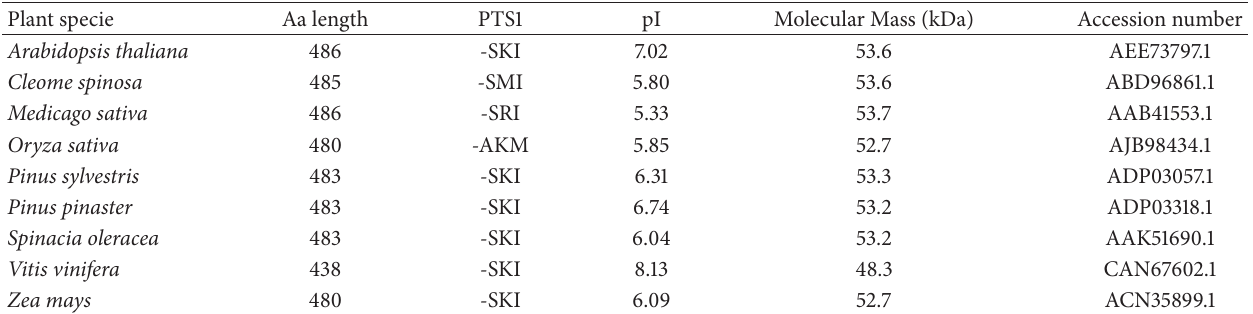
Table 1: Identification of 6PGDH proteins sequence of higher plants with a putative peroxisomal location for having a peroxisomal targeting signal type 1 (PTS1) on the C-terminal. The pI and MM values were calculated from their primary structure.